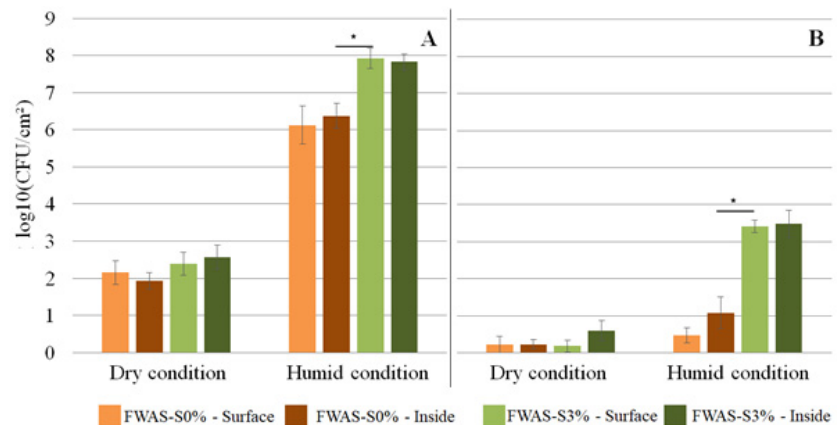
Figure 7. Bacterial (A) and fungal (B) Colony Forming Units (average ± standard deviation; two specimens sampled per condition) per cm² of adhesive, obtained by sampling the surface and the inside of specimens, depending on their moisture and composition conditions.